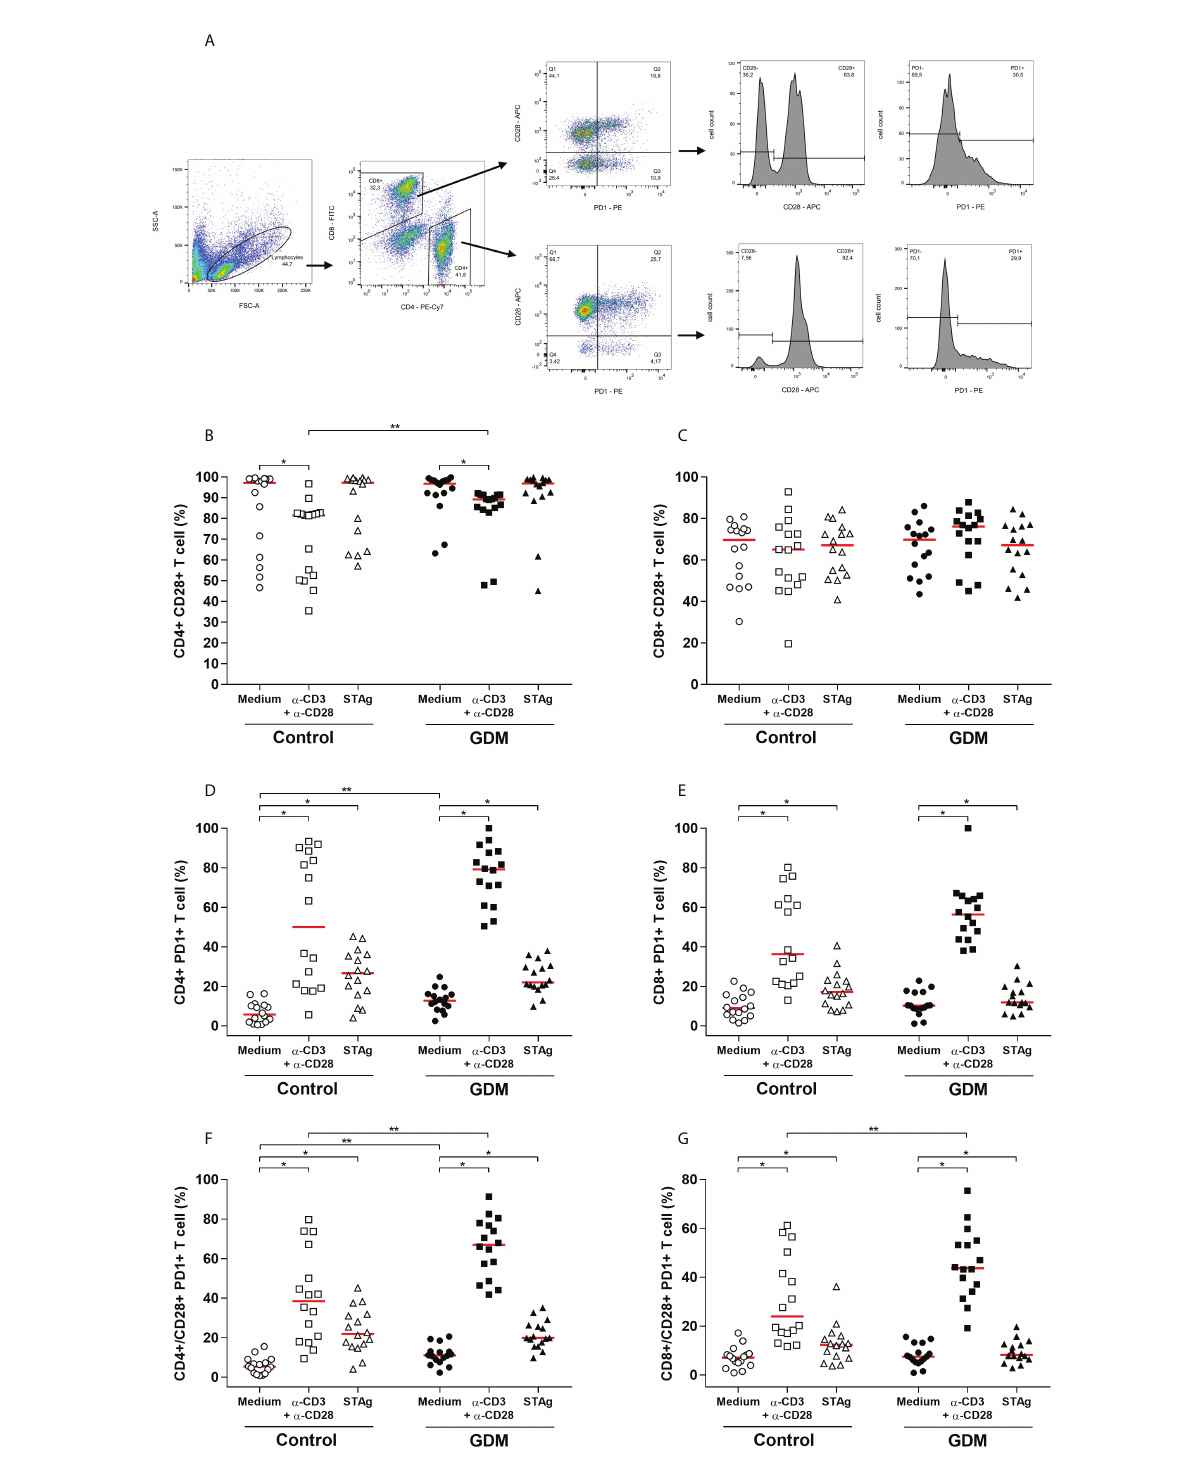
FIGURE 4 Activation and exhaustion of T lymphocytes, evaluated by the expression of CD28 and PD-1 cell surface receptors. (A) Gating strategy employed. Percentage (%) of (B) CD4 + CD28 + , (C) CD8 + CD28 + , (D) CD4 + PD-1 + , (E) CD8 + PD-1 + , (F) CD4 + /CD28 + PD-1 + , (G) CD8 + /CD28 + PD-1 + T cell, acquired by fl ow cytometry of PBMC cells from 32 pregnant women (16 GDM and 16 controls) after 96 hours culture in three different conditions (medium, polyclonal a -CD3/ a -CD28 stimulus and speci fi c STAg stimulus). The red line represents the median of the values. Statistically signi fi cant data, p < 0.05 *Wilcoxon **Mann-Whitney U test. GDM, Gestational diabetes